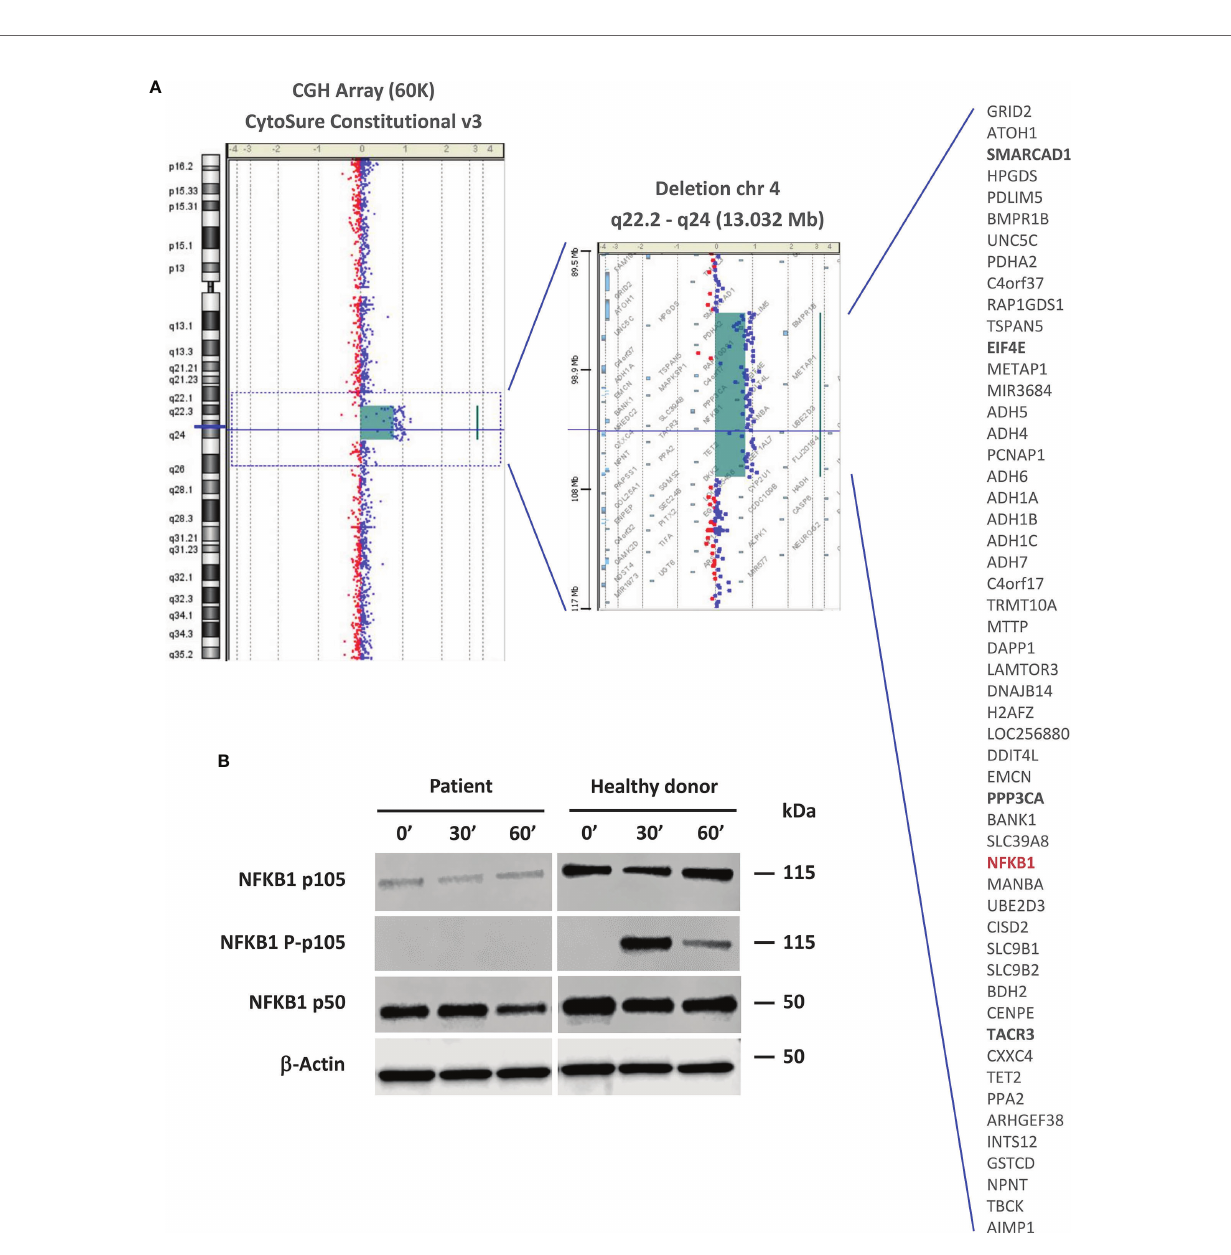
FIGURE 2 | Molecular and functional studies. (A) Array CGH-based identi fi cation of the 13-Mb deletion in the 4q22.2-q24 chromosomal region. Patient DNA was labeled with cyanine 3 (Cy3, red dots) and control DNA with cyanine 5 (Cy5, blue dots). The image is reported as the ratio of Cy5 and Cy3 fl uorescence intensity. The list of genes encompassed by this deletion is shown. Genes that are likely related to the patient ’ s non-immune clinical phenotype are in bold. The NFKB1 gene is highlighted in red. (B) NF-kB pathway evaluation by western blot. NFKB1 p105/p50 expression and activation were evaluated in PBMC-derived protein extracts from the patient and a healthy donor. For a better comparison between the healthy donor and patient, we quanti fi ed the p105 and p50 bands using the ImageJ software. The quanti fi cation re fl ects the relative amounts as a ratio of each protein band relative to the lane ’ s loading control ( b -actin): p105 patient (0 ’ : 0.24, 30 ’ : 0.20, 60 ’ : 0.22); p105 healthy donor (0 ’ : 0.79, 30 ’ : 0.76, 60 ’ : 1.10). p50 patient (0 ’ : 1.07, 30 ’ : 1.12, 60 ’ : 0.74); p50 healthy donor (0 ’ : 1.39, 30 ’ : 1.27, 60 ’ :